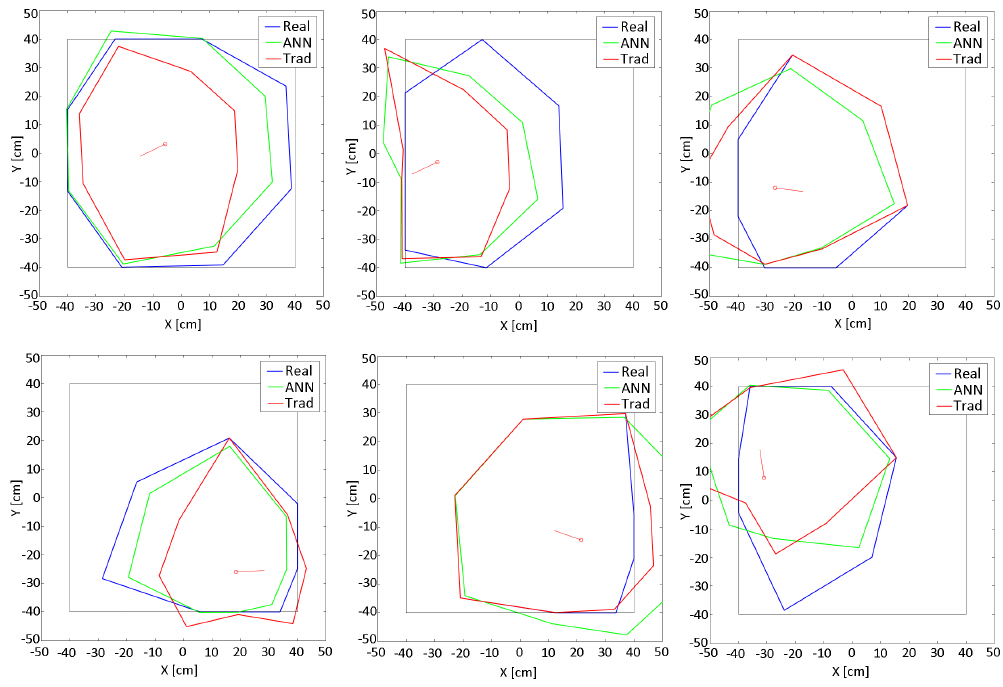
Figure 13. Images sequence of a test in the